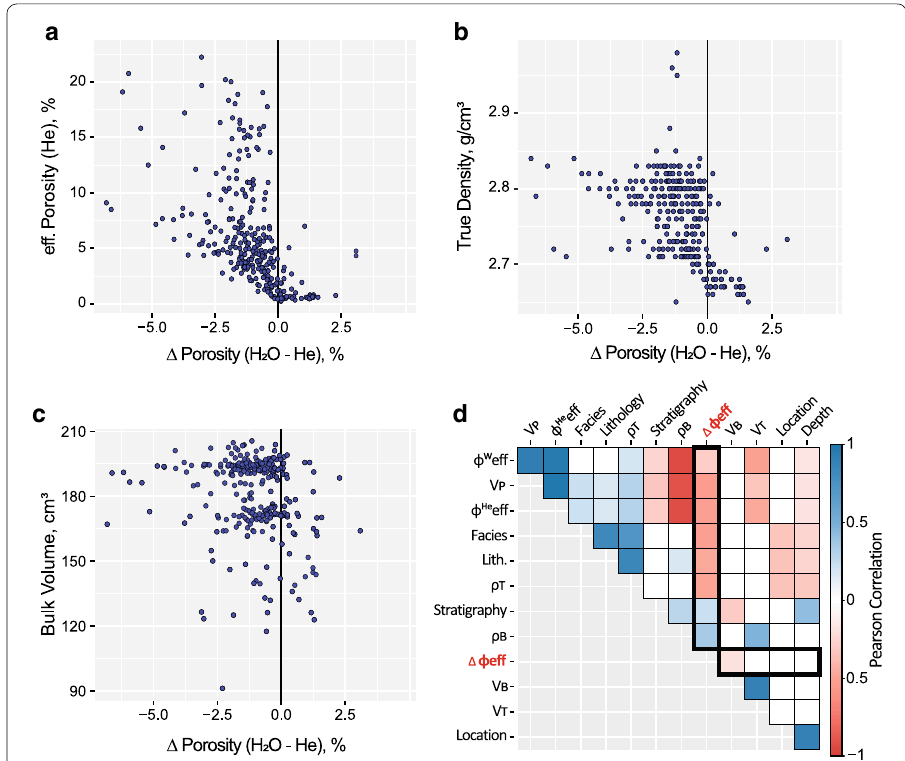
Fig. 18 Dependency of porosity deviation between HEP and WIP methods related to different factors. a Porosity deviation becomes increasingly negative with increasing porosity. A positive deviation was mainly found for samples with low porosity. b Correlation of the porosity deviation with grain density suggests a dependency on lithology. c The porosity deviation seems not to be related to bulk volume (i.e., dimensions) of the sample. d The matrix shows the Pearson correlation coefficients of different parameters. Blue color represents a positive correlation, whereas red represents a negative correlation. ( φ He eff effective porosity = (HEP), φ w eff effective porosity (WIP), ρ B bulk density, ρ T grain density, V B bulk volume, V T helium = = = = = grain volume, V P pore =